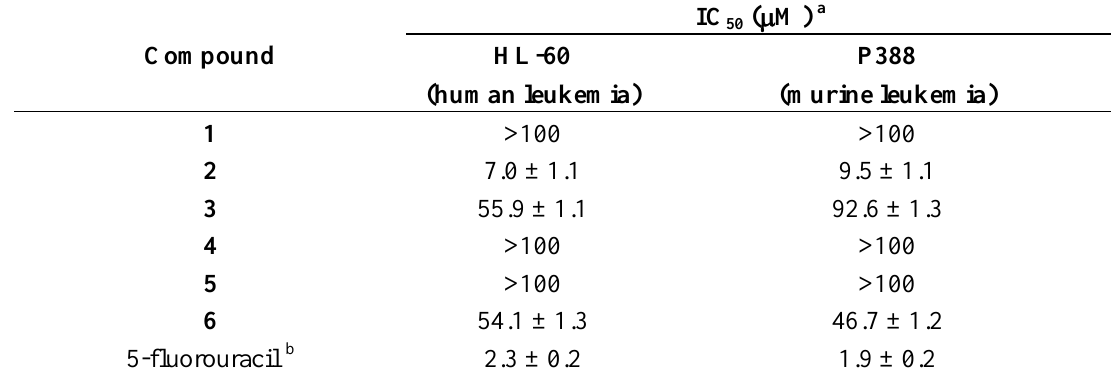
Table 3. Cytotoxic activities of multiflorane-type triterpenes from Cucurbita maxima seeds.